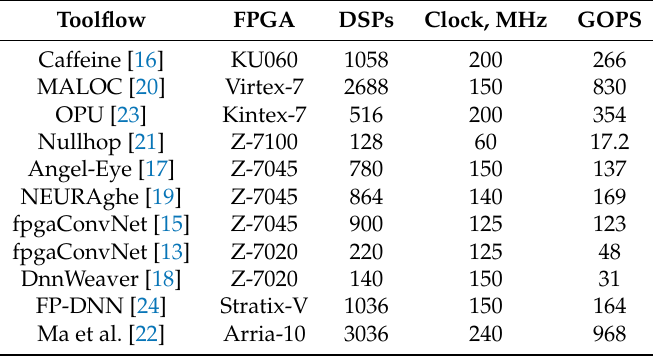
Table 1. Toolflows for automated mapping of CNNs to